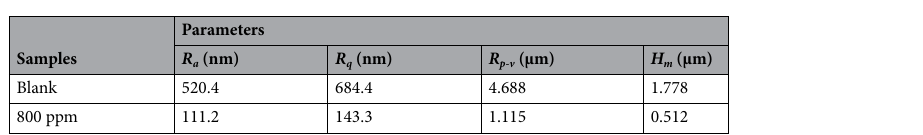
Table 5. AFM parameters of MS surface dipped in 1 M HCl solution in the presence and absence of 800 ppm FV extract.